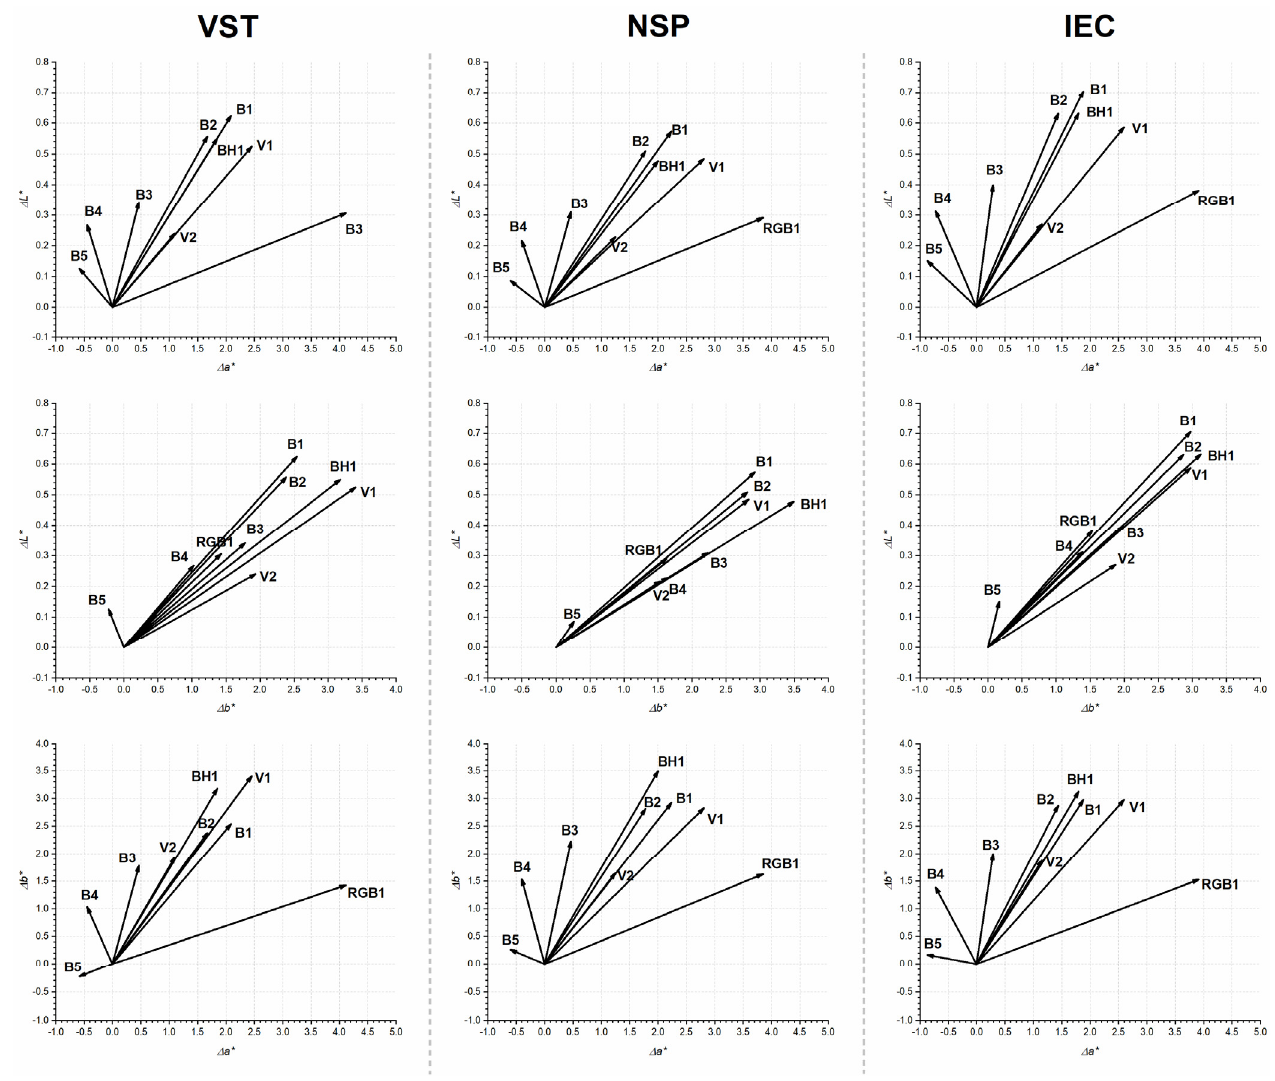
Figure 4. Projections of the color shifts produced by each one of the nine LED illuminants on the 𝑎 ∗ 𝑏 ∗ , 𝑎 ∗ 𝐿 ∗ , and 𝑏 ∗ 𝐿 ∗ planes, using as common origin the coordinates under illuminant D65 for shade A1. Results for the three dental ceramics analyzed are distinguished (left: VST; center: NSP; right: IEC).